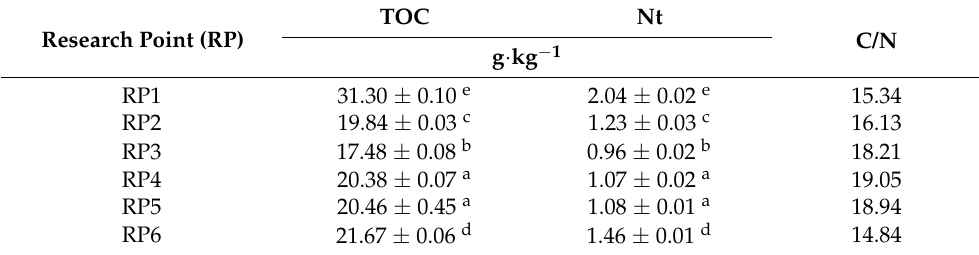
Table 3. Total Organic Carbon (TOC), Total Nitrogen (Nt) Content, and C/N ratio. Research Point (RP)